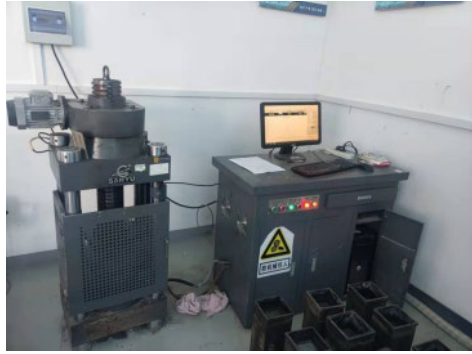
Figure 2. Cubic samples for unconfined compressive strength tests.